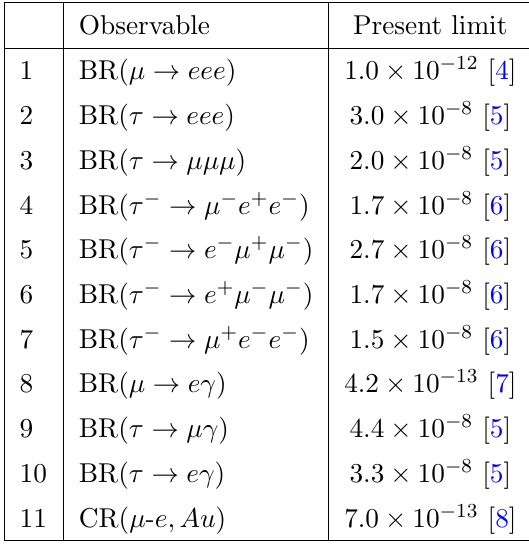
Table 2 . Current experimental bounds on the branching ratios of the three-body decay l i ! l j l k l l , the l i ! l j (cid:13) transition and the (cid:22) $ e conversion